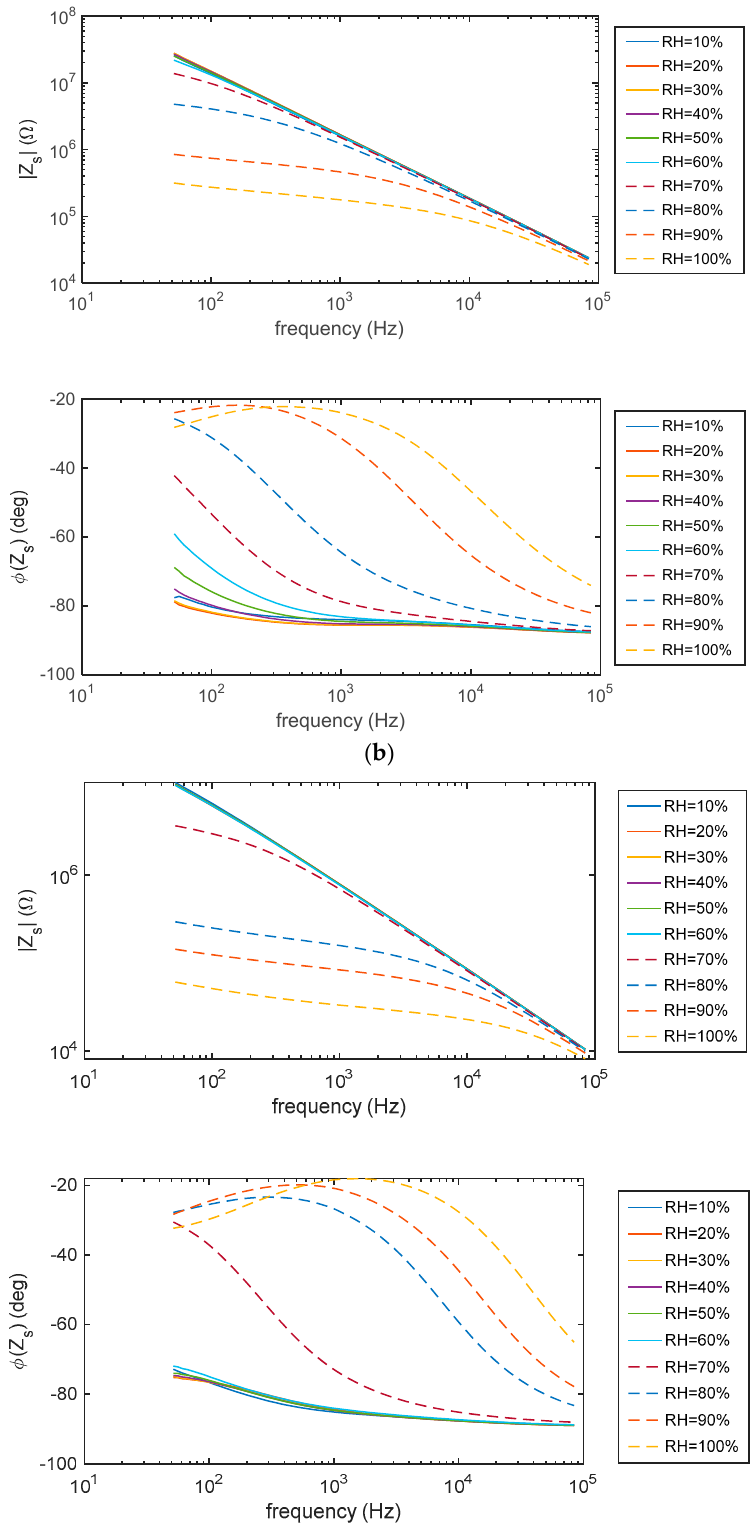
Figure 9. Impedance of the tested sensing devices in the range 50 Hz − 80 kHz: ( a ) TiO 2 sample; ( b ) TiO 2 Au1 sample; ( c ) TiO 2 Au2 sample. The reported measurements were obtained after 1 h of exposure to constant and controlled RH levels as per legend.